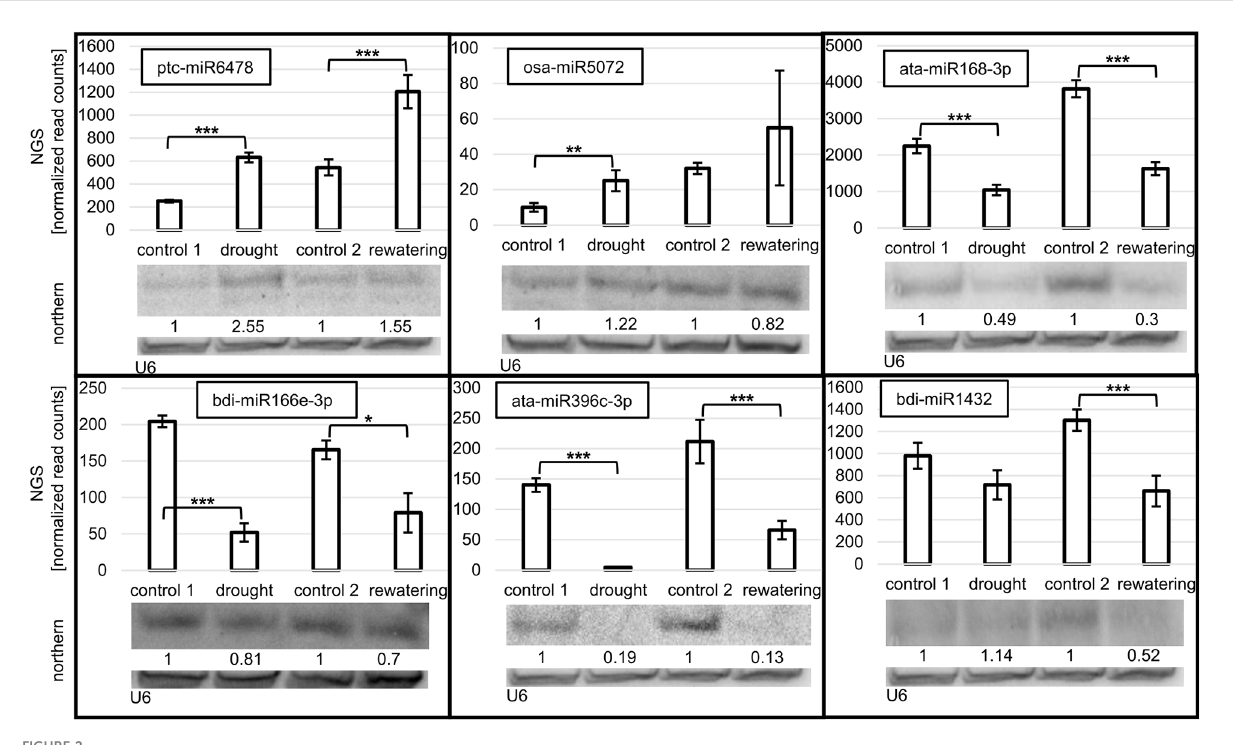
FIGURE 2 Accumulation of selected miRNAs in drought and rehydration established by northern and compared to next-generation sequencing (NGS) normalized read counts. The signi fi cance of the observed NGS differences was calculated with the DESeq package in R (***p ≤ 0.001, **p ≤ 0.01, and *p ≤ 0.05). Numbers below blot images are relative intensities of the miRNA bands, Control signals in each blot were treated as 1. The microRNA hybridization signal was corrected with U6 as a loading control. MiRNAs for northern analysis were selected to con fi rm the different accumulation pro fi les of various miRNAs during drought and rehydration revealed by